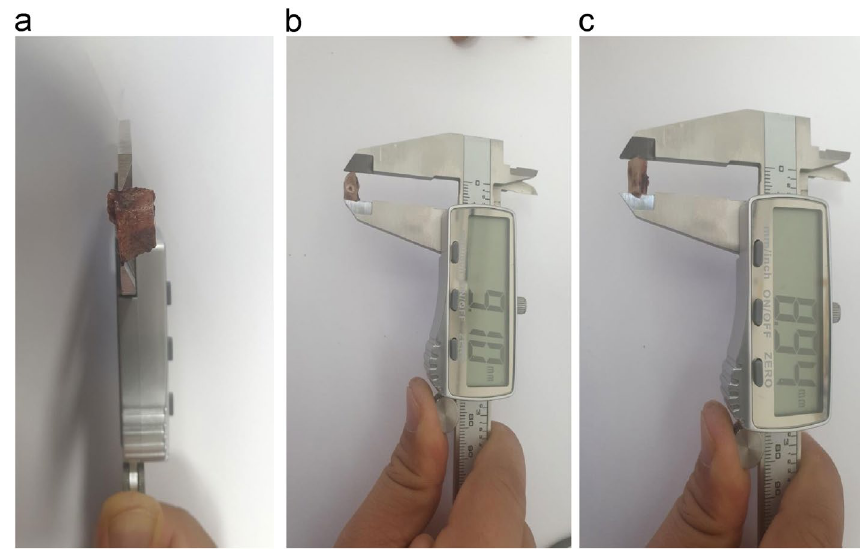
Fig. 5 Measurement of the length of the actual resected bone. a Height of the posterior resection part; b height of the anterior resection part; c anteroposterior length of the lower